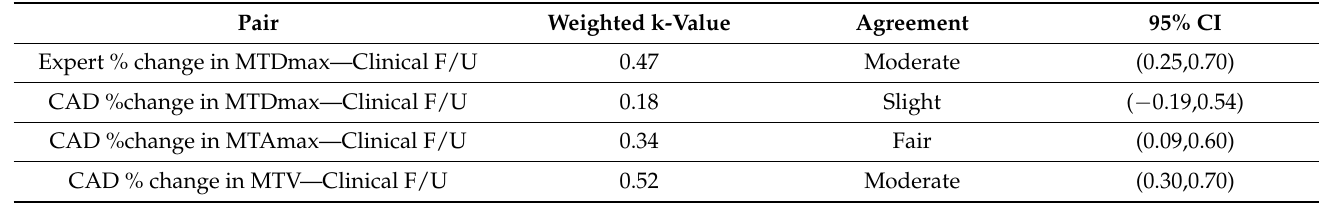
Table 4. Weighted Cohen Kappa statistic for the agreement between the expert’s and CAD’s classifica- tion of patients based on changes in metabolic parameters and the clinical outcome; linear weighting was used. The type of agreement suggested by the kappa value and the 95% confidence interval (CI) is also